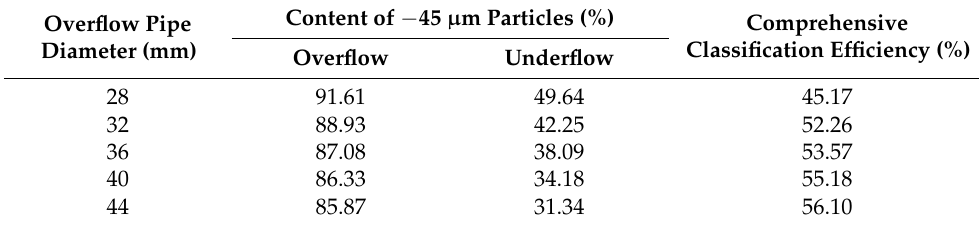
Table 6. Effect of the overflow pipe diameter on the classification performance of the